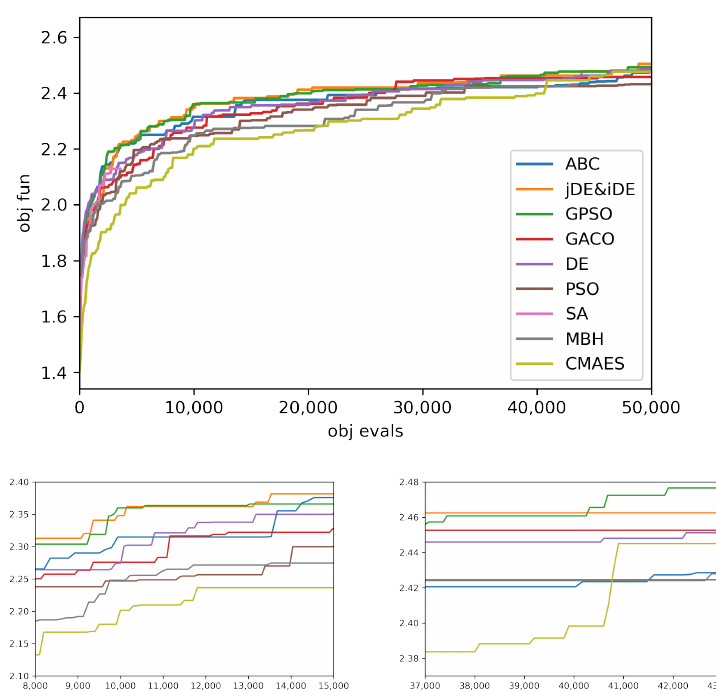
Figure 3. Average rate during fitness evaluation ( N = 9).